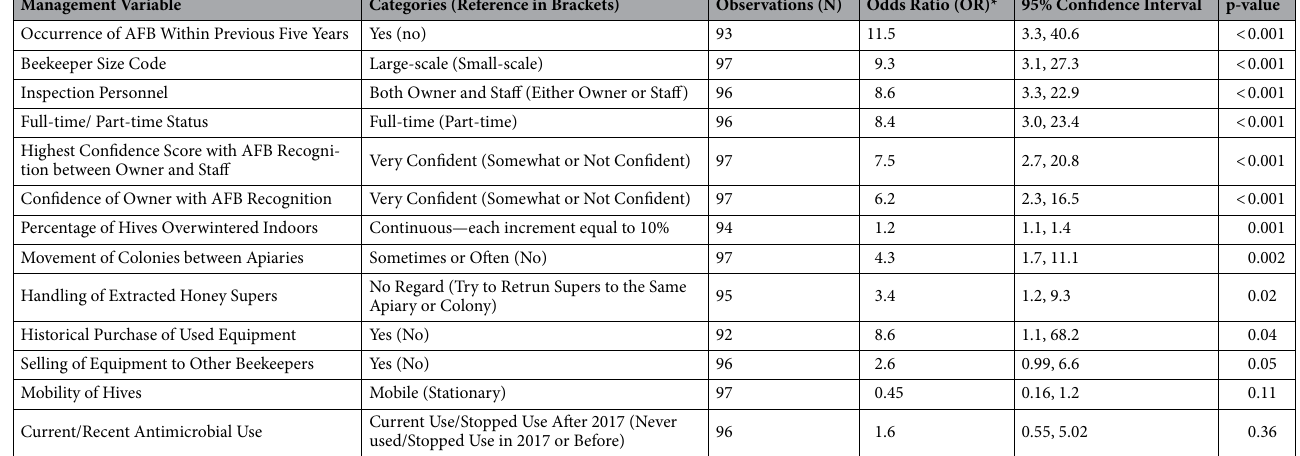
Table 1. Odds ratios for individual management practices with moderate/high and high future AFB risk categories as an outcome. Only variables with > 65 observations and a p-value of < 0.3 are included, with the